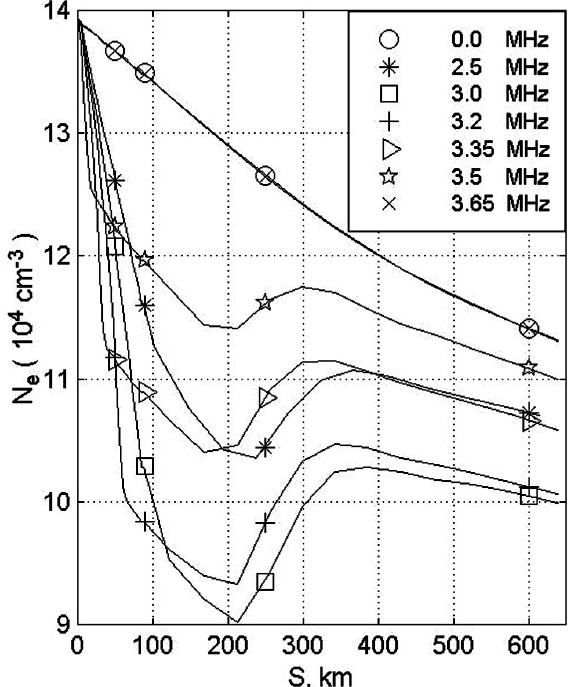
Fig. 6. The variations of the electron concentration (in units of 10 4 cm − 3 ) along the considered part of the convection trajectory at level h = 350km. The captions are the same as in Fig. 5.